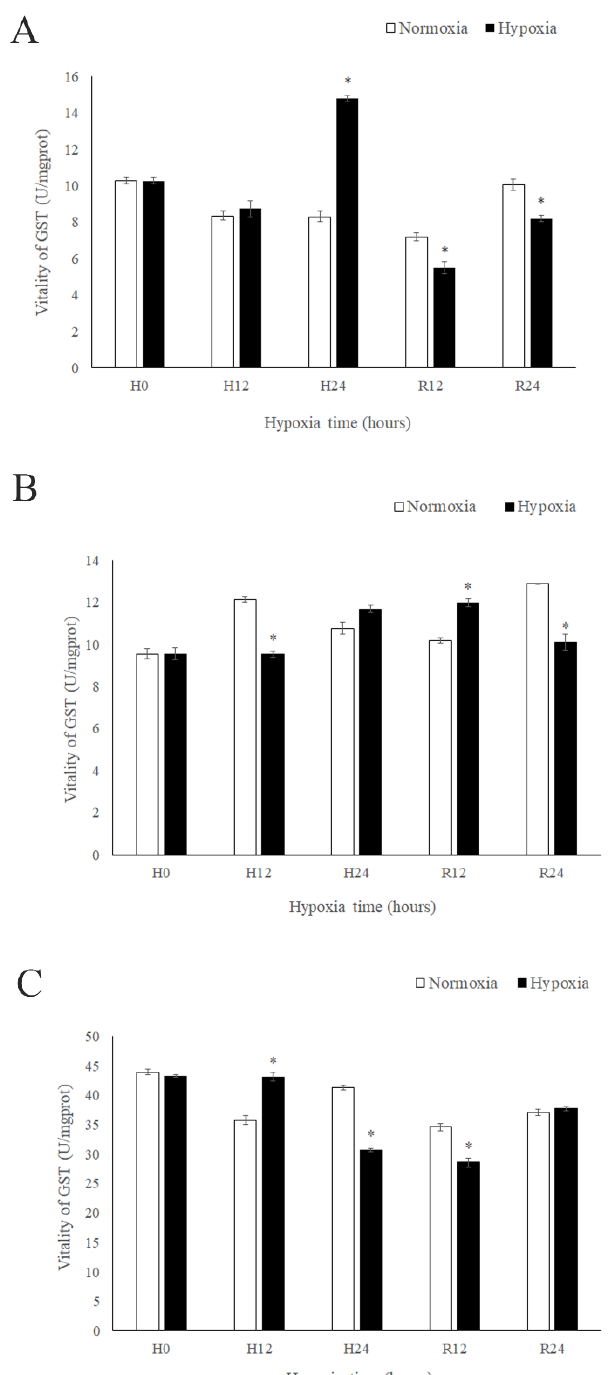
Figure 6. Enzyme activity of GSTs in the hepatopancreas ( A ), gill ( B ) and muscle ( C ) of M. nipponense at five time points after hypoxia and reoxygenatio (H0: hypoxia for 0 h; H12: hypoxia for 12 h; H24: hypoxia for 24 h; R12: reoxygenation for 12 h; R24: reoxygenation for 24 h). Data indicated with asterisks are significantly different ( p < 0.05) between treatment and control groups. Values are means ± SE for triplicate samples.